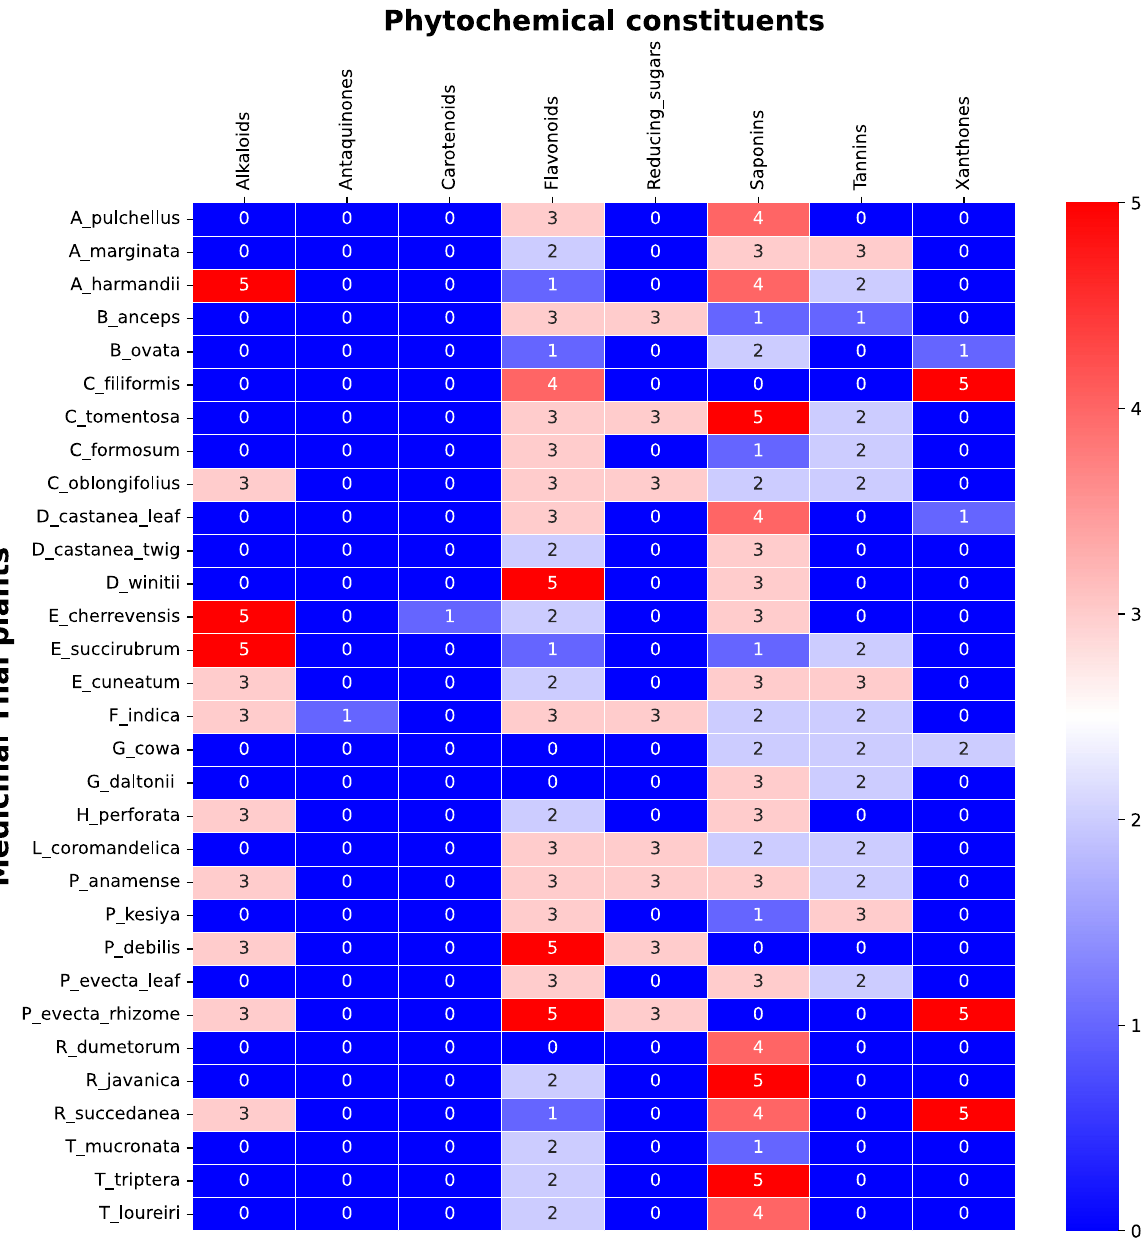
Commented [TS3]: New Figure (Correct typo in plant part from Rhizome to rhizome, and flavonoids to Flavonoids)